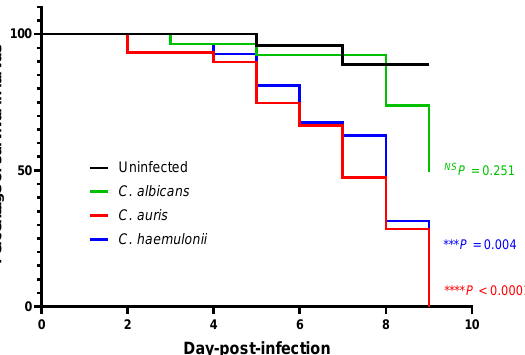
Figure 2. Emerging Candida virulence in a zebrafish model. Each experimental group of 26 zebrafish was injected with 10 7 CFU cells of one of the C. albicans ATCC24433 (control) strain, C. auris strain SI-18-CAU-HEM, or C. haemulonii strain SI-21-CH-PLF. Each experiment was performed in duplicate.